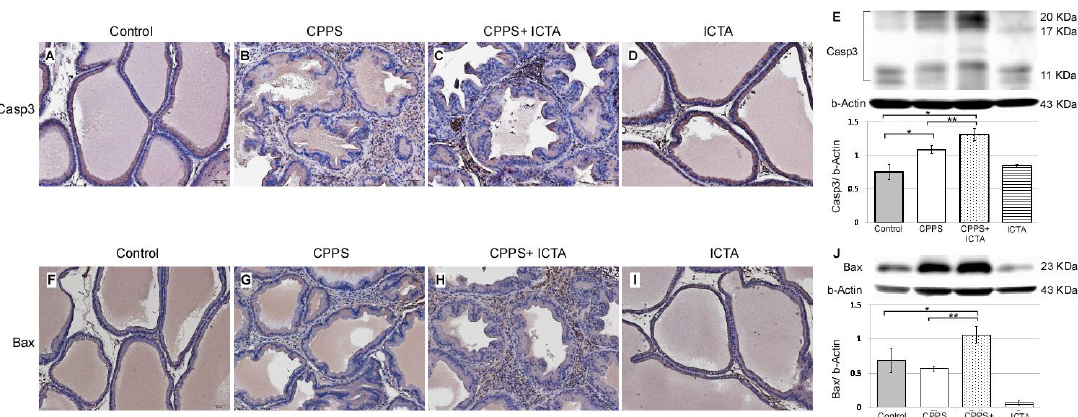
Figure 5. Inflammatory cytokine-targeting aptamers (ICTA) significantly induces apoptosis after neutralizing local interleukin-1 beta (IL-1b) and tumor necrosis factor-alpha (TNF-a) responses in the carrageenan-induced chronic pelvic pain syndrome (CPPS) rat model ( n = 6). ( A – D ) Immunohistochemical staining results show that ICTA prominently promoted pro-caspase-3 expression and cleavage in CPPS prostate ( C ) compared with those in the CPPS only ( B ) and control groups ( A ). Carrageenan injection also resulted in procaspase-3 expression, but this was more pronounced when CPPS was treated with ICTA. ( E ) Western blot results show 106% and 140% increases of activated caspase-3 expression in the CPPS + ICTA group when compared with the CPPS group and control, respectively. ( F – I ) Immunohistochemical staining results show that ICTA prominently promoted B-cell lymphoma 2-associated X protein (BAX) expression and cleavage in the prostate of the CPPS + ICTA group ( H ) compared with those in the CPPS group ( G ) and control group ( F ). ( J ) Western blot results show that there were 86% and 54% increases of BAX expression in the CPPS + ICTA group when compared with the CPPS group and control, respectively.